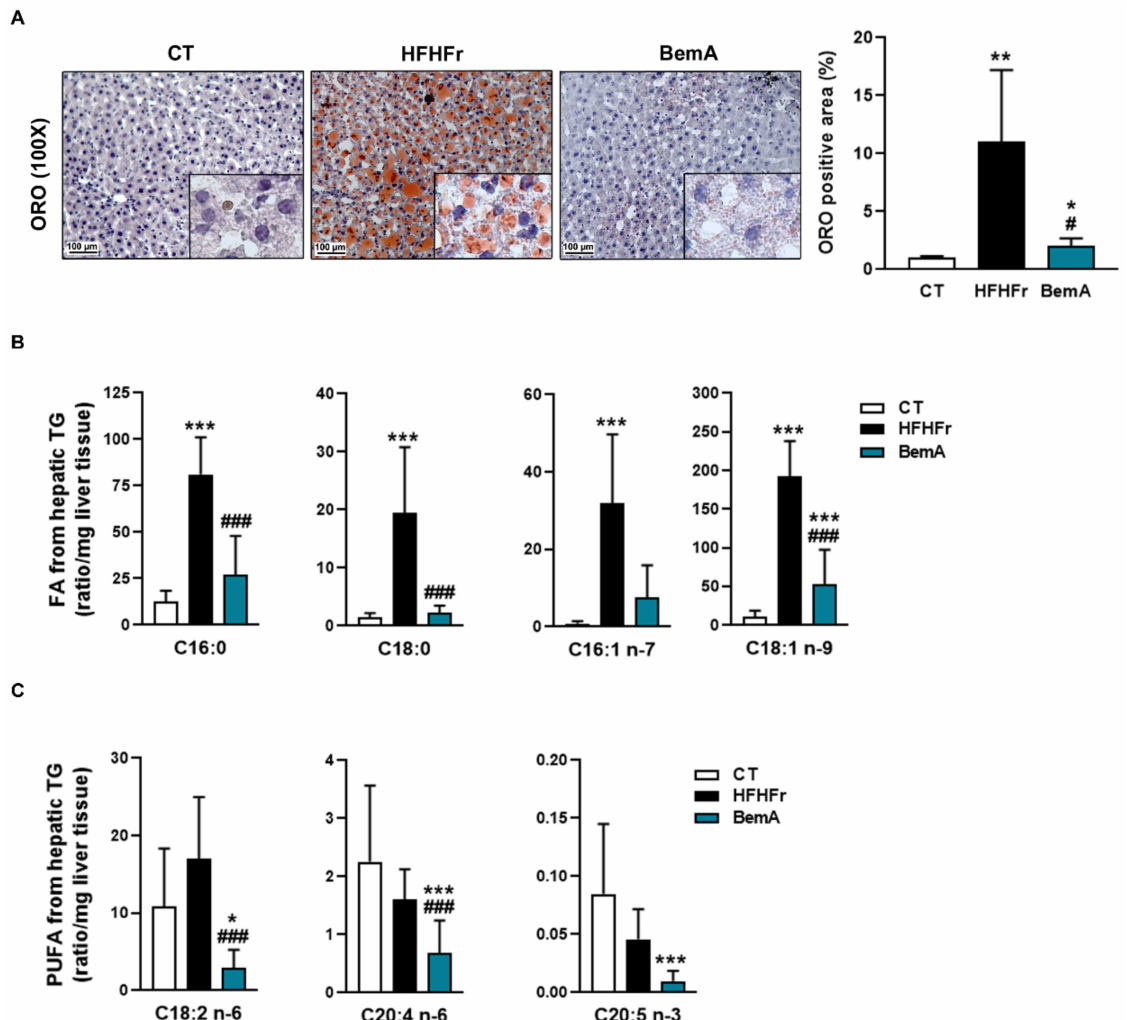
Figure 4. Bempedoic acid reduces liver steatosis and the amount of fatty acids from hepatic triglyc- erides. ( A ) Images of Oil Red O-stained sections, and quantification of the positive stained area, in livers from control (CT), high-fat, high-fructose (HFHFr), and bempedoic acid (BemA)-treated rats. Amount of saturated and monounsaturated ( B ), and polyunsaturated fatty acids (PUFA) ( C ) in liver triglycerides from CT, HFHFr, and BemA groups. The results are expressed as the mean ± SD of 7–8 animals/group. Data were analyzed by one-way ANOVA, followed by Tukey’s post-hoc * p < 0.05, ** p < 0.01, *** p < 0.001 compared to CT; # p < 0.05, ### p < 0.001 compared to HFHFr.